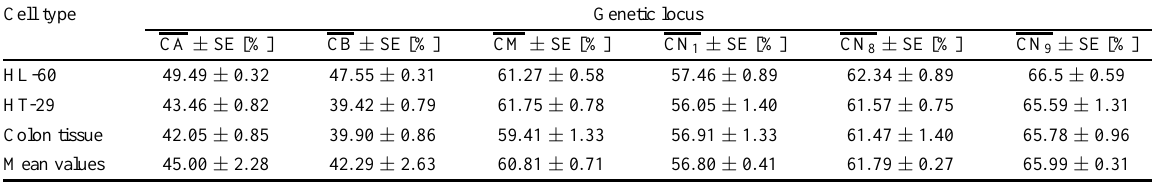
Average values and standard errors of centre-of-nucleus to signal 2D distributions for the ABL, BCR and c-MYC genes and chromosome centromeres 1, 8 and 9